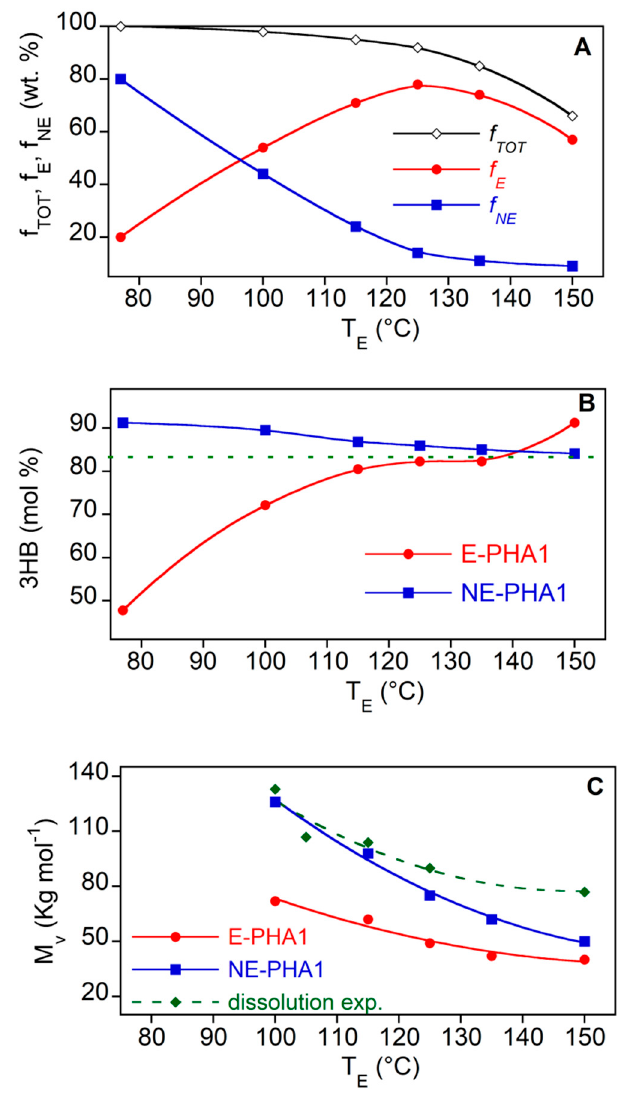
Figure 4. Total ( f TOT ), extracted ( f E ) and non-extracted ( f NE ) PHA fractions ( A ), composition ( B ) and average viscosimetry molecular weight ( C ) of E-PHA1 and NE-PHA1 as a function of extraction temperature T E with EA. The dotted line in ( B ) is the composition of R-PHA1. The green diamond marks in ( C ) are the molecular weight of R-PHA1 after the dissolution experiments already reported in Figure 3. All the lines are guides for the eyes.